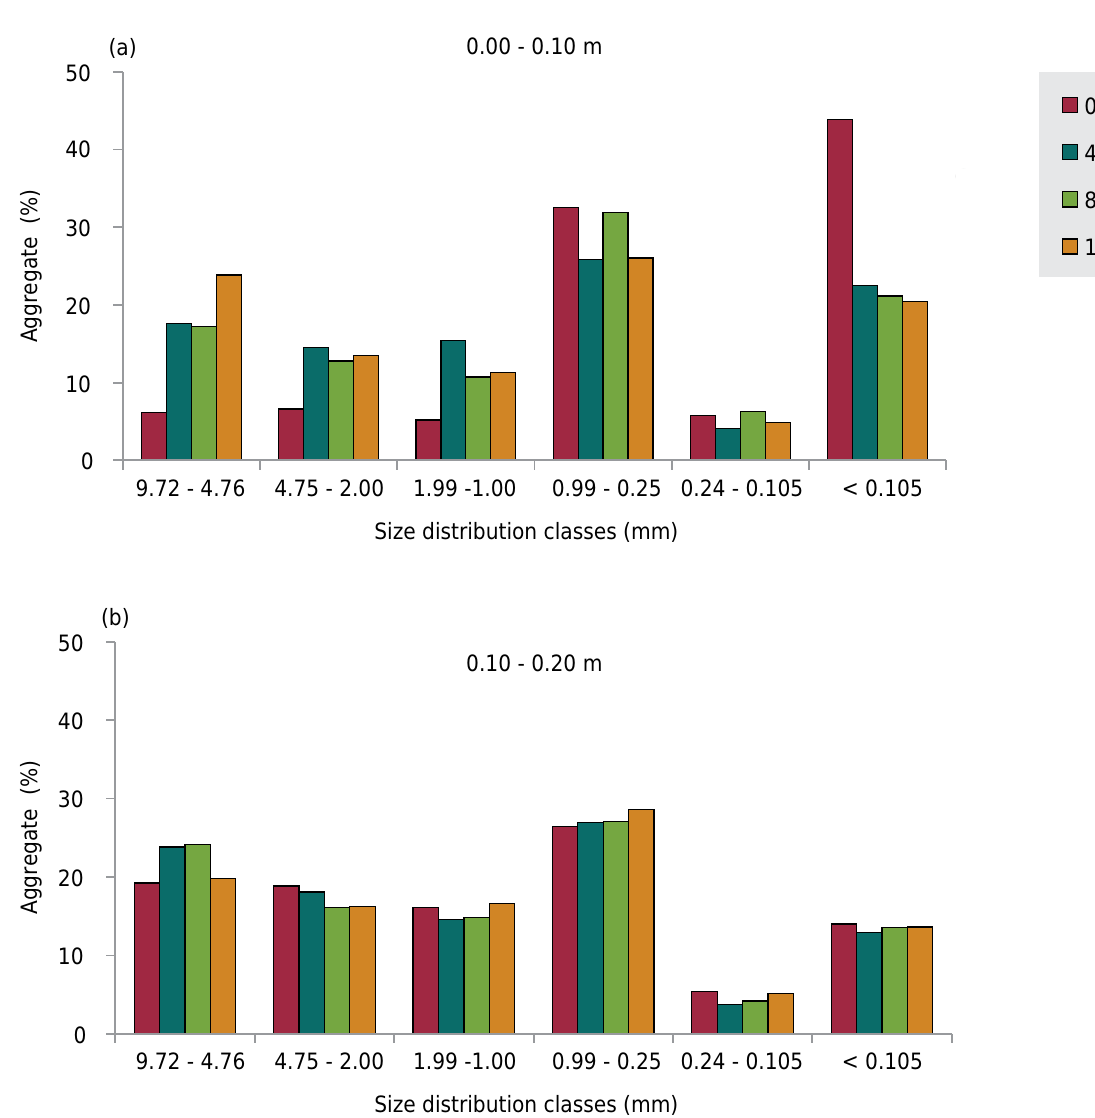
Figure 2. Distribution of water stable aggregates per size classes of a Typic Hapludult under different rates of rice husk ash in the 0.00-0.10 (a) and 0.10-0.20 m (b)